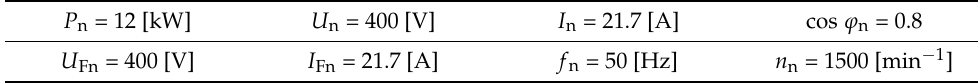
Table 7. Manufacturer’s data of the tested synchronous generator.